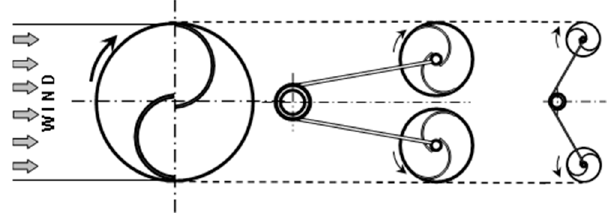
Figure 8. Comparison of innovative wind turbines and Savonius rotor.